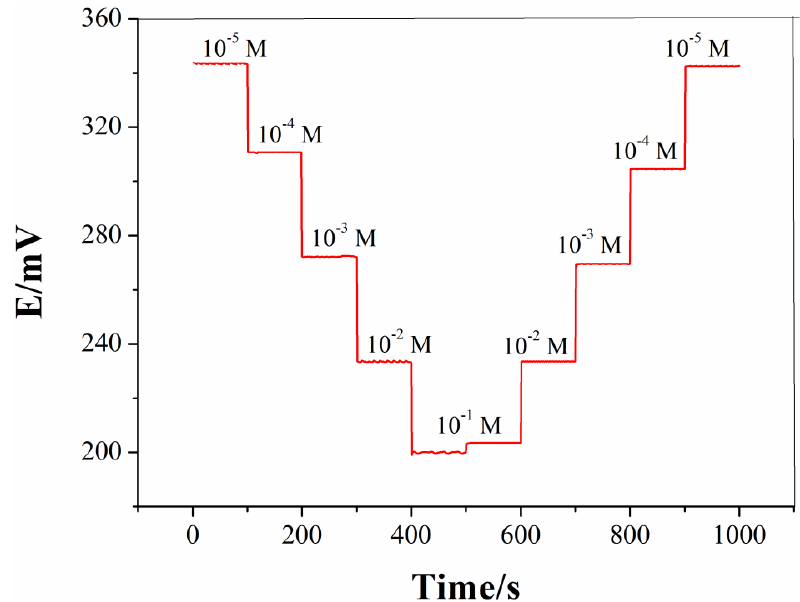
Figure 1. The calibrated curve of the silicate Ion-Selective Electrode (ISE) for Na 2 SiO 3 solutions with concentrations ranging from 10 − 5 M to 10 − 1 M.